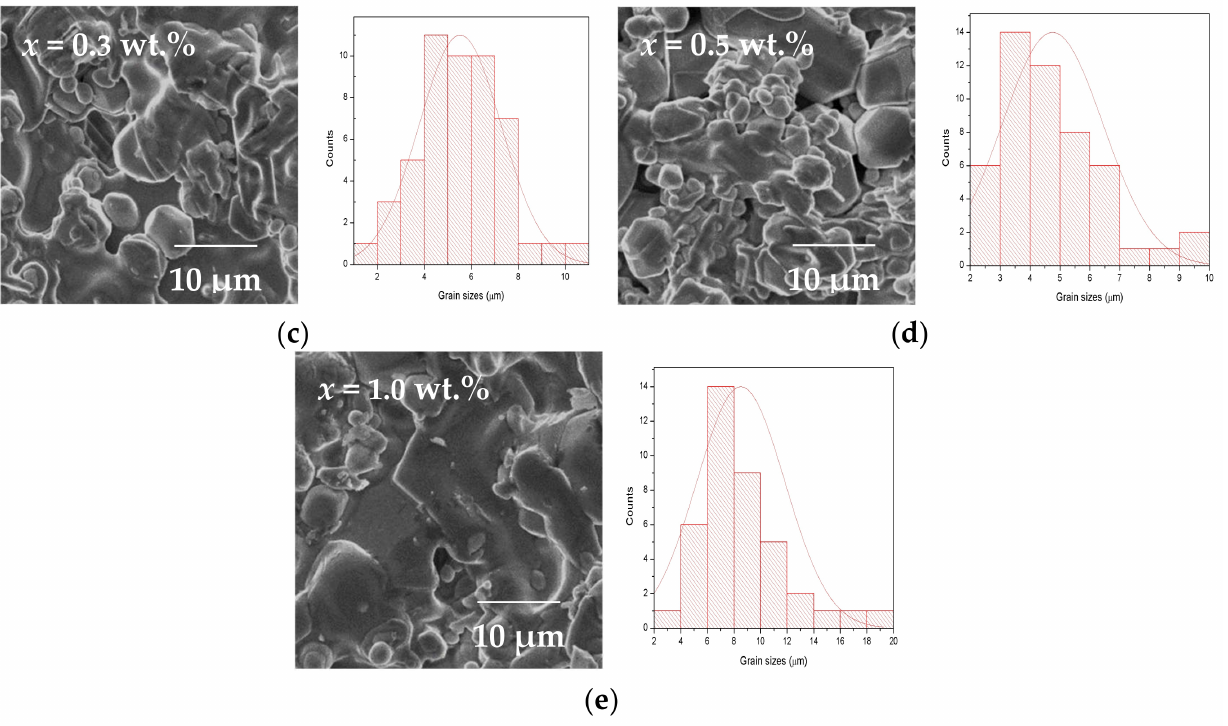
Figure 3. ( a – e ) FESEM images and histogram of average grains of Y123 with various additions of graphene nanoparticles measured from image J software under 1000 ×